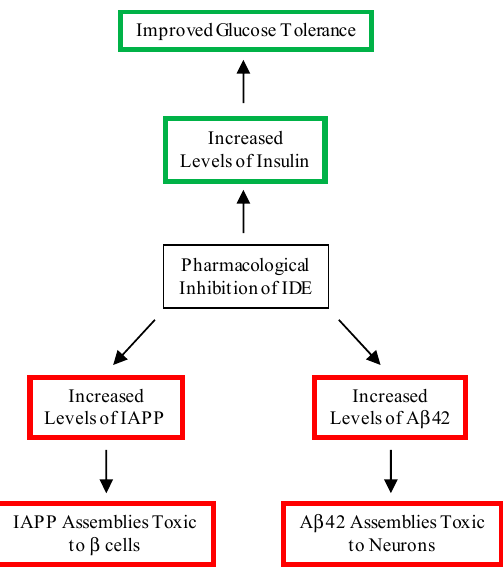
Figure 2. Beneficial and deleterious consequences of the pharmacological inhibition of IDE. A beneficial consequence of the inhibition of IDE is increased levels of insulin, leading to an improvement in glucose tolerance. Deleterious consequences include increased levels of A β 42 and IAPP, leading to the formation of cytotoxic assemblies in the brain and pancreas, respectively.